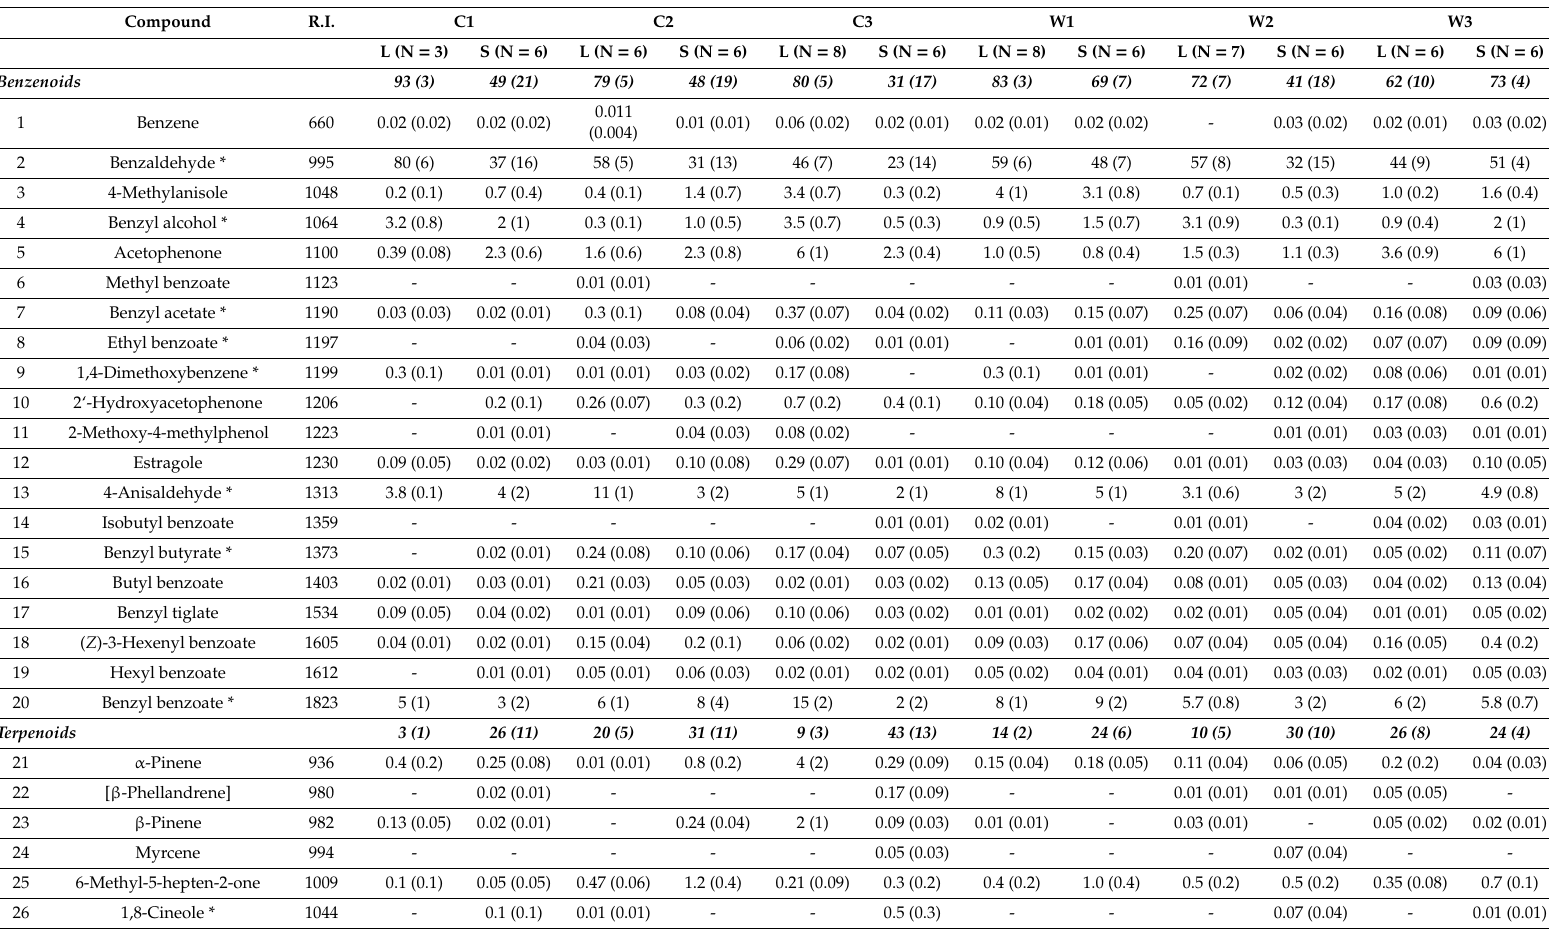
Table 1. Mean (s.e.) relative amounts of volatile organic compounds (VOCs) ( ≥ 0.01%) in L and S flower morphs from three cultivated (C1, C2, C3) and three wild (W1, W2, W3) populations of G. sempervirens . All scent compounds, except in brackets, were verified using standards. Unverified compounds were identified with > 90% matches to library spectra and literature R.I. values. Compounds with significantly di ff erent relative amounts in L verses S flowers ( p < 0.05) are indicated with an